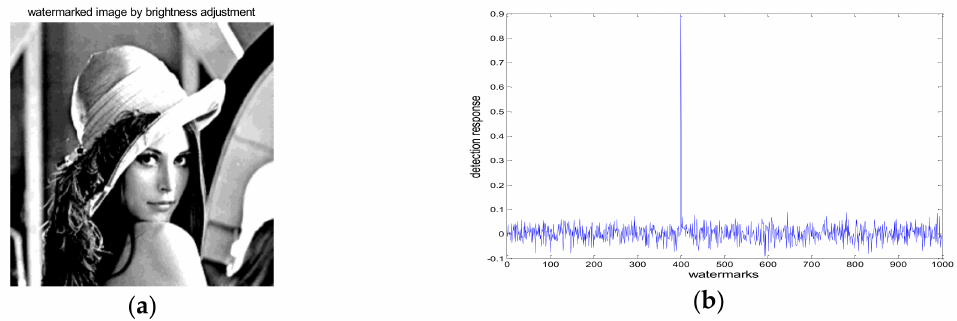
Figure 12. ( a ) Brightness adjustment attack; ( b ) detector